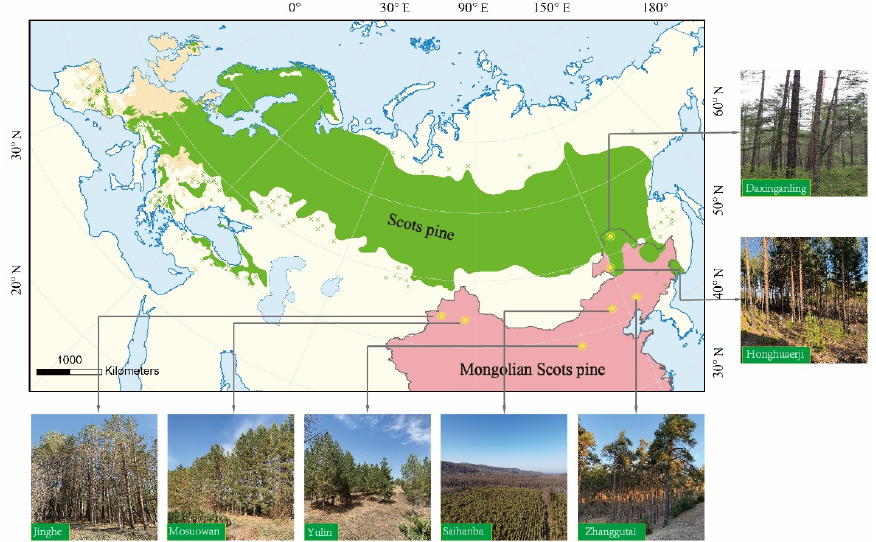
Figure 1. Distribution area of Scots pine (redrawn from distribution maps available in http://www.euforgen.org/species, accessed on 21 April 2022) and study sites (circles) of Mongolian Scots pine in China. Scots pine is naturally distributed in China and is named Mongolian Scots pine. The two photos to the right of the map show two kinds of natural forests: one is mountain-land-typed Mongolian Scots pine; the other is sandy-land-typed Mongolian Scots pine. The bottom five photos show five places with Mongolian Scots pine plantations in northern China. From right to left, they are Zhanggutai (in Horqin Sandy Land), Saihanba (in Otindaq Sand Land), Yulin (in Mu Us Sandy Land), Mosuowan (at the edge of Gurbantunggut Desert), and Jinghe (at the edge of alluvial gobi).